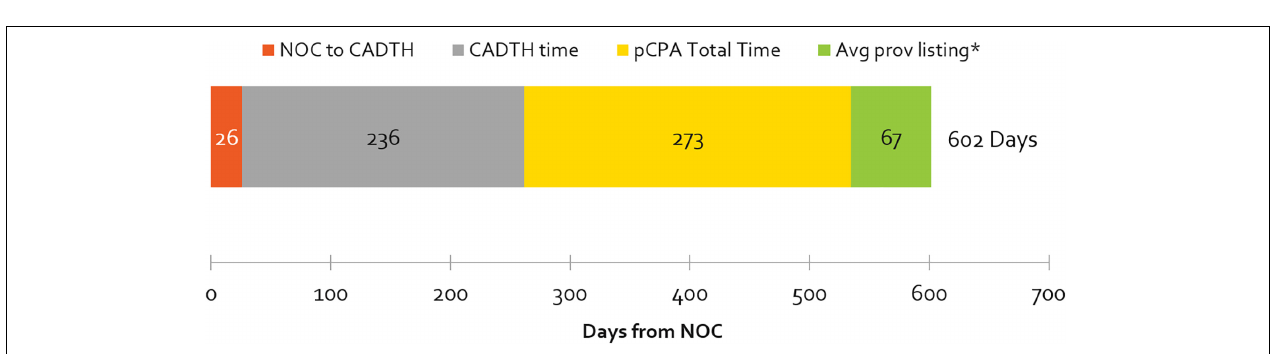
FIGURE 2 | Number of products that have completed a CADTH HTA review (2012- December 2015), a pCPA negotiation, and achieved at least one provincial listing or country-wide listing as of December 2016. Yes, passed the respective review step; Active, still under review on December 31, 2016; n/a, review not yet begun; No, did not pass the respective review step; Inaccessible, not available as a reimbursed benefit to eligible beneficiaries in the plan(s) – reflects the filtering effect.